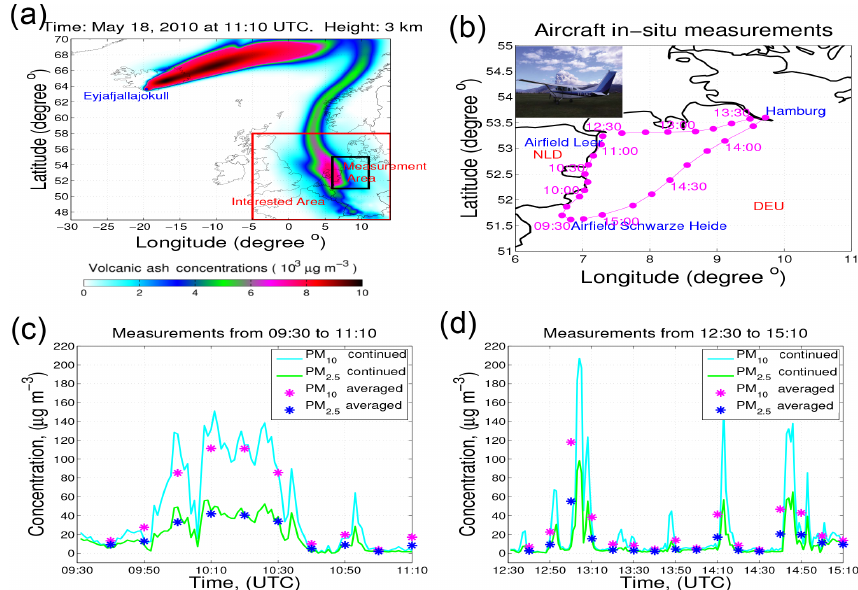
Figure 1. Aircraft in situ measurements of distal volcanic ash plume. (a) The LOTOS-EUROS simulation of volcanic ash plume at 11:10UTC, 18 May 2010. (b) Measuring aircraft flight route on 18 May 2010. (c) PM 10 and PM 2 . 5 measurements from 09:30 to 11:10UTC. (d) PM 10 and PM 2 . 5 measurements from 12:30 to 15:10UTC. In (c, d) , the curves show the values of PM 10 and PM 2 . 5 measured at a frequency of every 6s. The values marked with a star are the averaged PM 10 and PM 2 . 5 (average every 10min) which are used in the LOTOS-EUROS model in accordance with the model simulation step